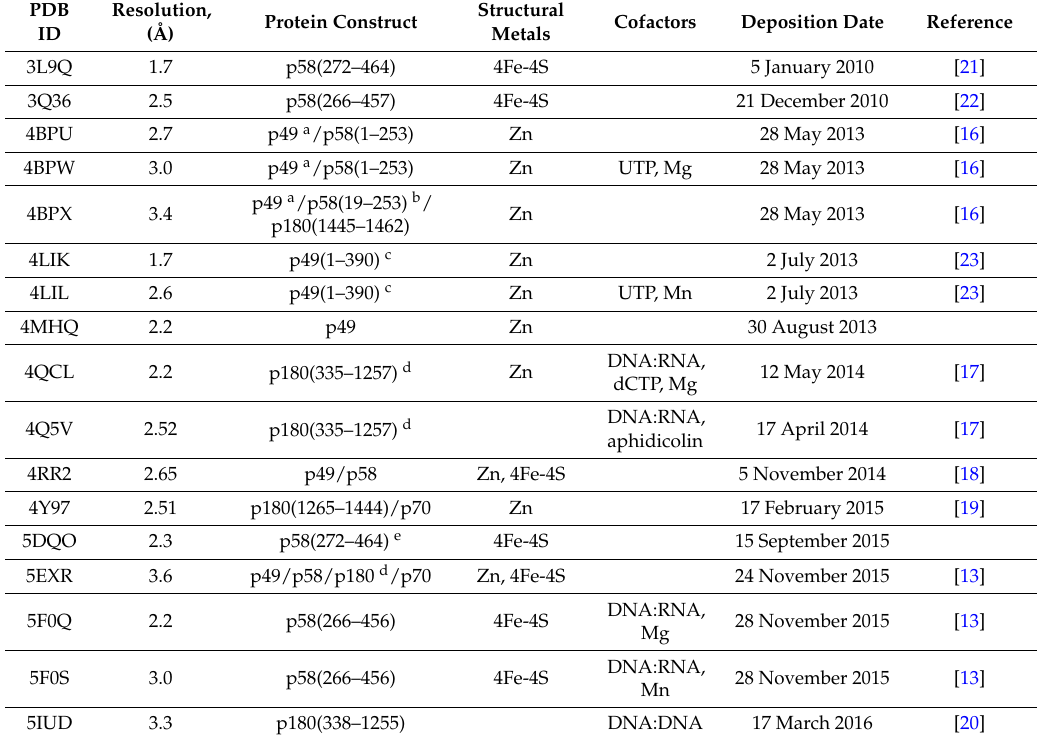
Table 1. List of the high-resolution structures of the human primosome and its